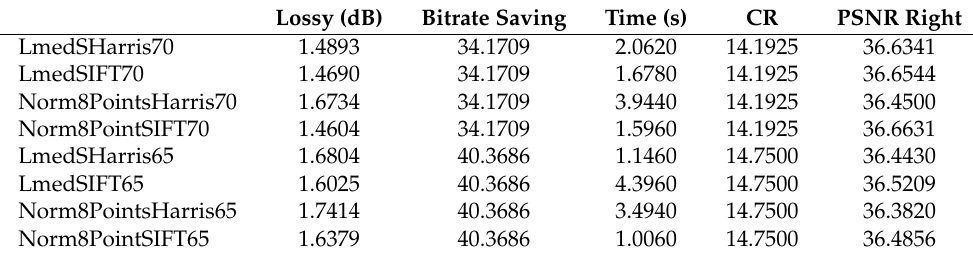
Table 6. Performance of the [20] method applied on the LIVE 3D dataset [34].